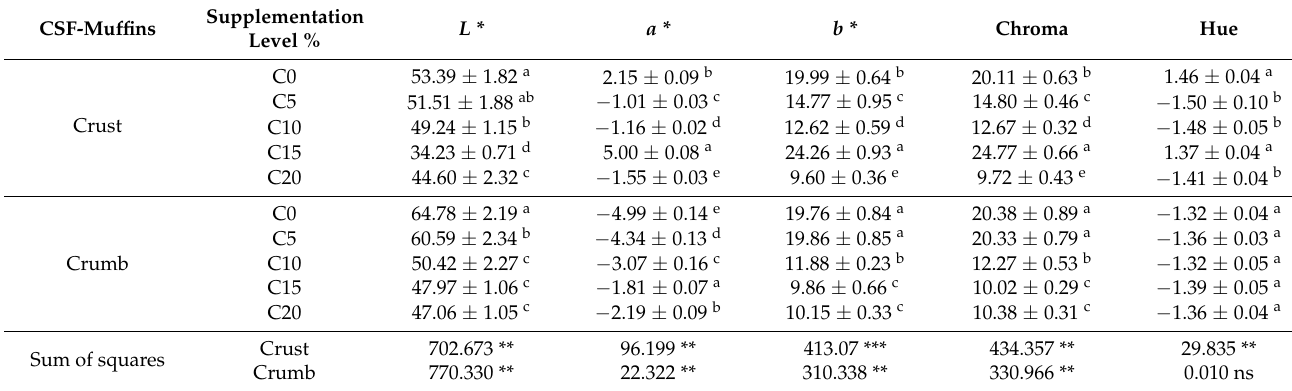
Table 5. Color indices (mean ± SD) and their sum of squares of CSF-muffins.